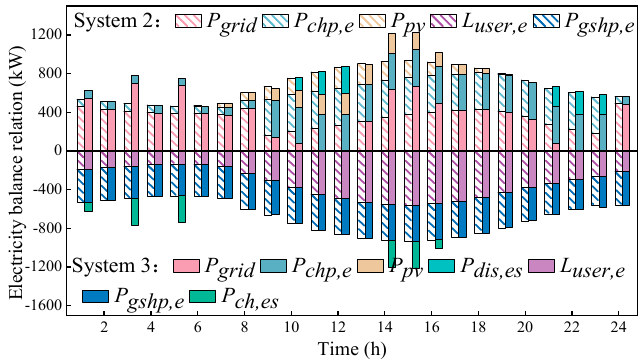
Figure 9. Electricity scheduling process of system 2 and system 3.